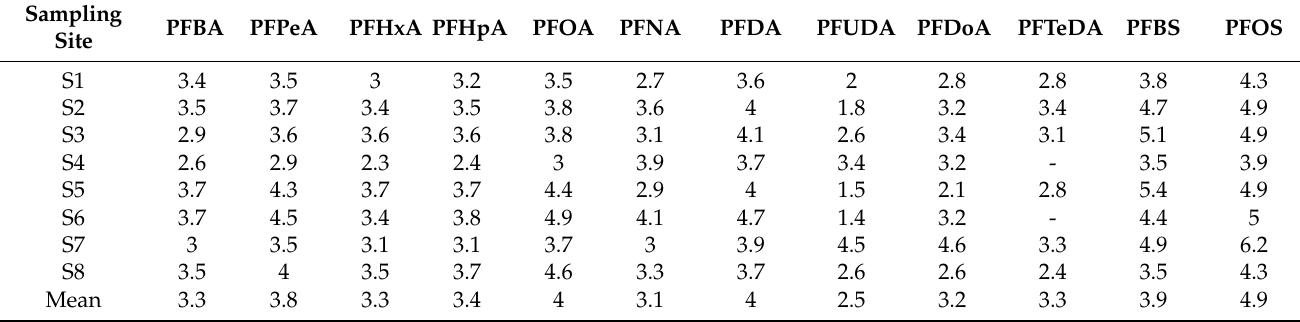
Table 2. The distribution coefficient values of selected PFAS in water and